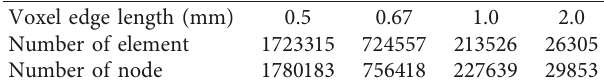
Table 1: Four types of numerical model element and node